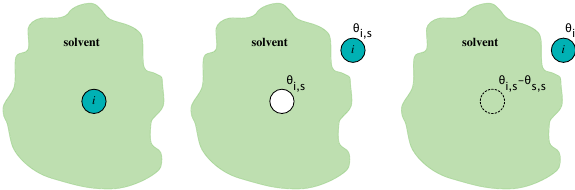
Fig. A1. Solvation energy conceptualized. A molecule, i (teal cir- cle), is disolved in a solvent s . To evaporate it must be removed from the solvent, leaving a void and costing energy θ i,s to both the molecule and the solvent; the solvent will relax to fill the void, re- leasing energy θ s,s